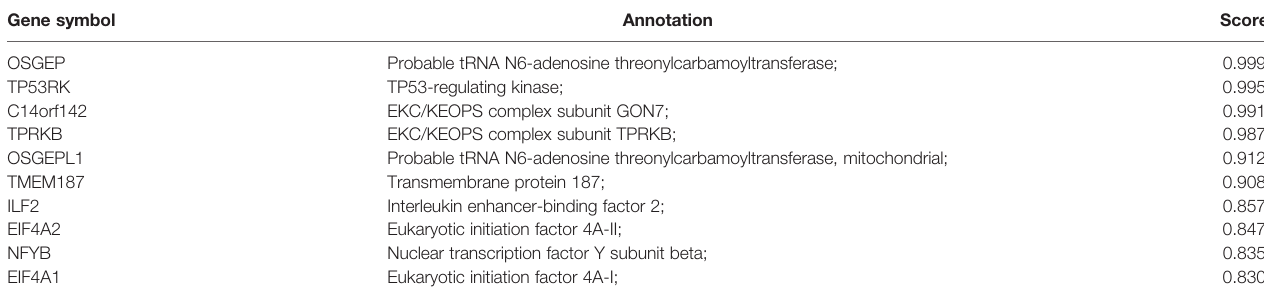
TABLE 2 | Predicted functional partners of LAGE3 protein.